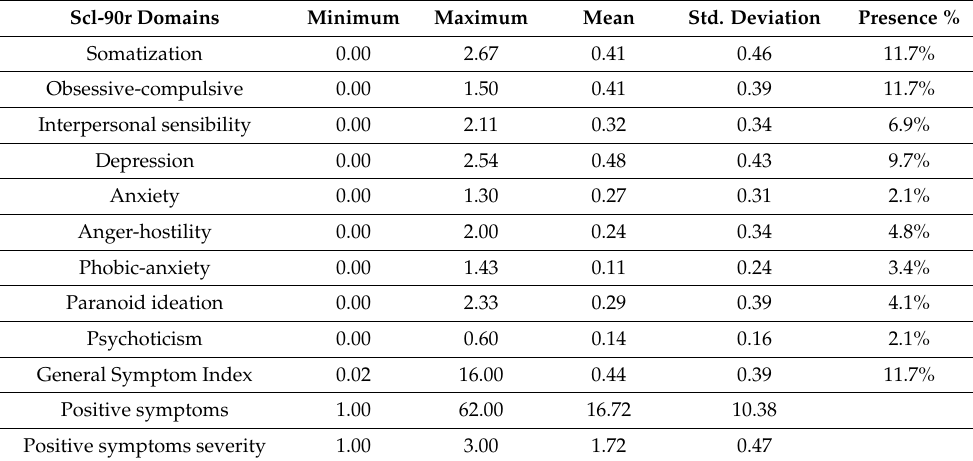
Table 3. Descriptive statistics of Symptom Checklist